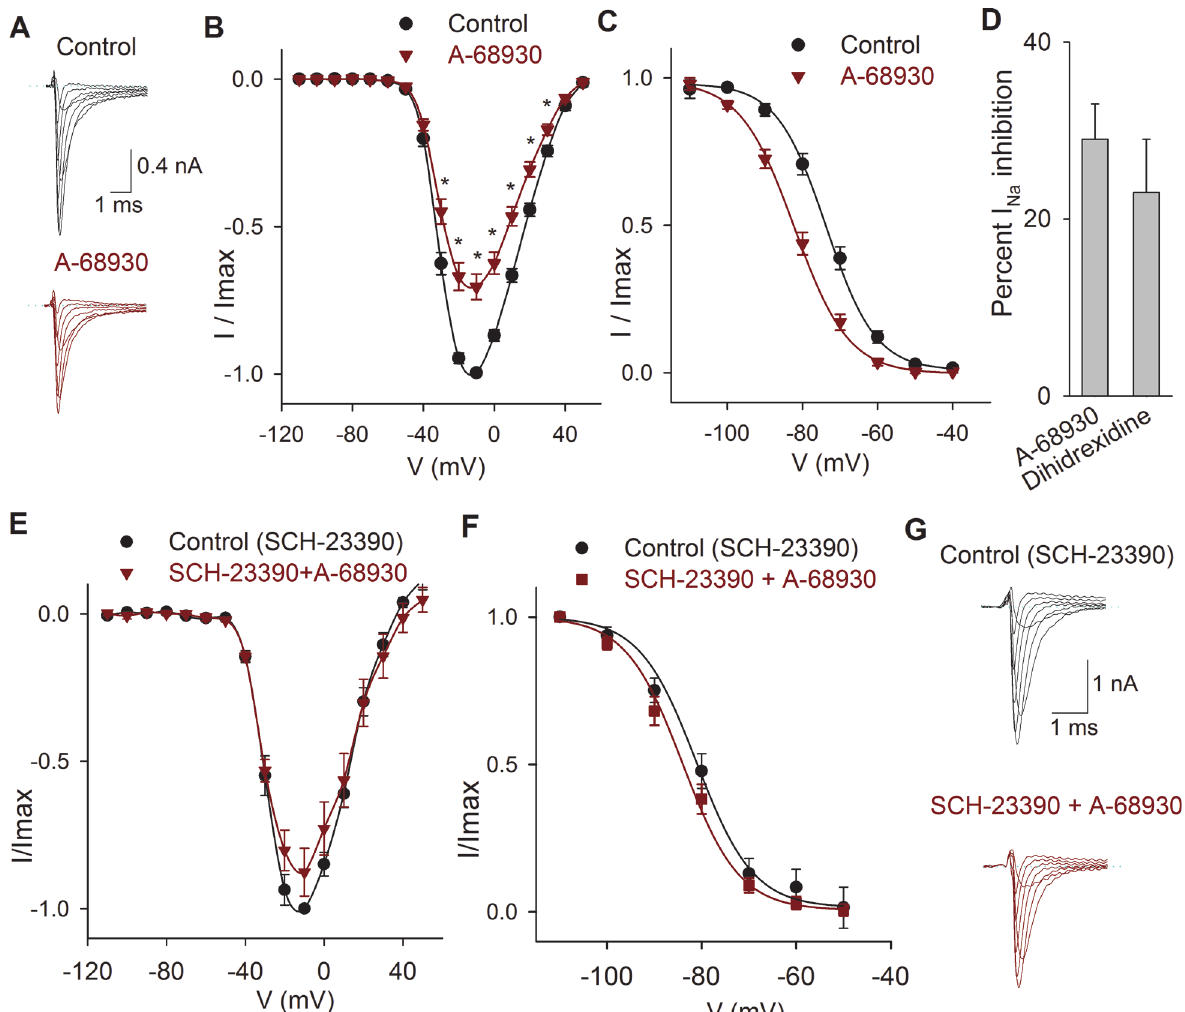
Fig 4. Effects of D1 related drugs on the I Na . A) Recordings of the I Na in control condition and after perfusion of A-68930 (300 nM). B) Current-voltage relationship of the I Na under control conditions and after 300 nM A-68930. The maximum decrease of the current was 29 ± 4% at − 10 mV. C) Steady state inactivation of the I Na in control conditions and after 300 nM A-68930, which caused a leftward shift of the inactivation. D). Bar graph comparing the inhibitory effect of 100 nM dihidrexidine with A-68930 effect. Non-significant difference was found ( P = 0.445; unpaired t-test ). E) Current-voltage relationship of the I Na in control conditions (with 100 μ M SCH-23390), and after the co-application of 300 nM A-68930. F) Steady state inactivation of the I Na in control (with 100 μ M SCH-23390) and after A-68930 + SCH-23390, which caused non-significant changes. G) Typical recordings of the I Na showing that SCH-23390 significantly reduced the inhibitory action of 300 nM